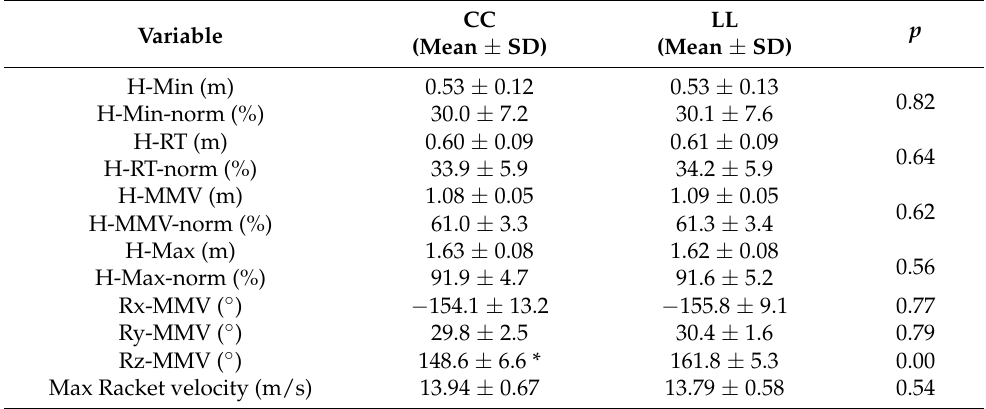
Table 1. Mean SD values of the examined kinematic variables in both the CC and LL conditions. CC = cross-court; LL = long-line. * p < 0.05.